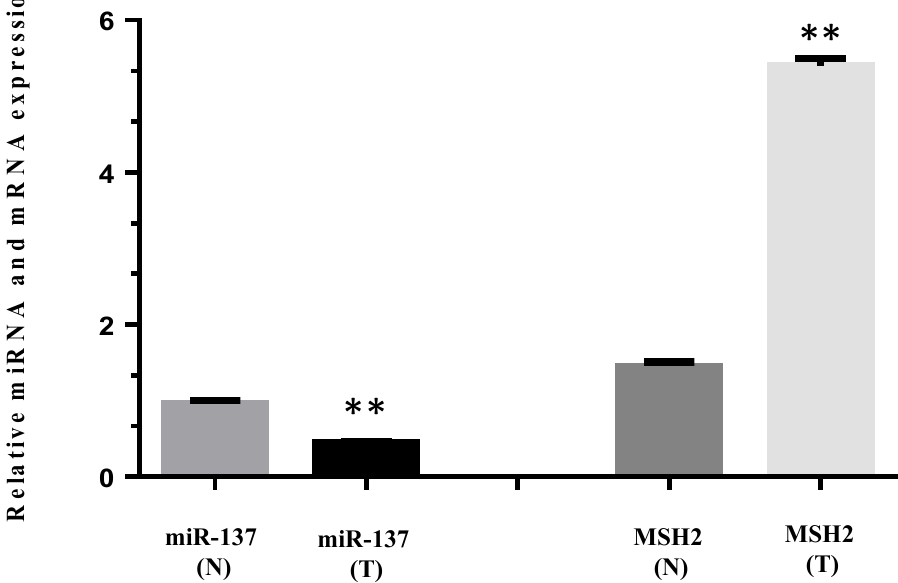
Figure 3. Relative pre-miR-137 and MSH2 mRNA expression in normal (N) and tumor (T) colon tissue from a patient carrying the c*226>G variant in the MSH2 3 ′ UTR. Pre-miR-137 levels were determined by qRT-PCR and normalized to small nucleolar RNA RNU6B. MSH2 mRNA levels were normalized to GAPDH . All data represent the mean ± standard deviation (SD) of 4 independent experiments. Statistical significance was determined by Student’s t -test with a ** p < 0.0001.